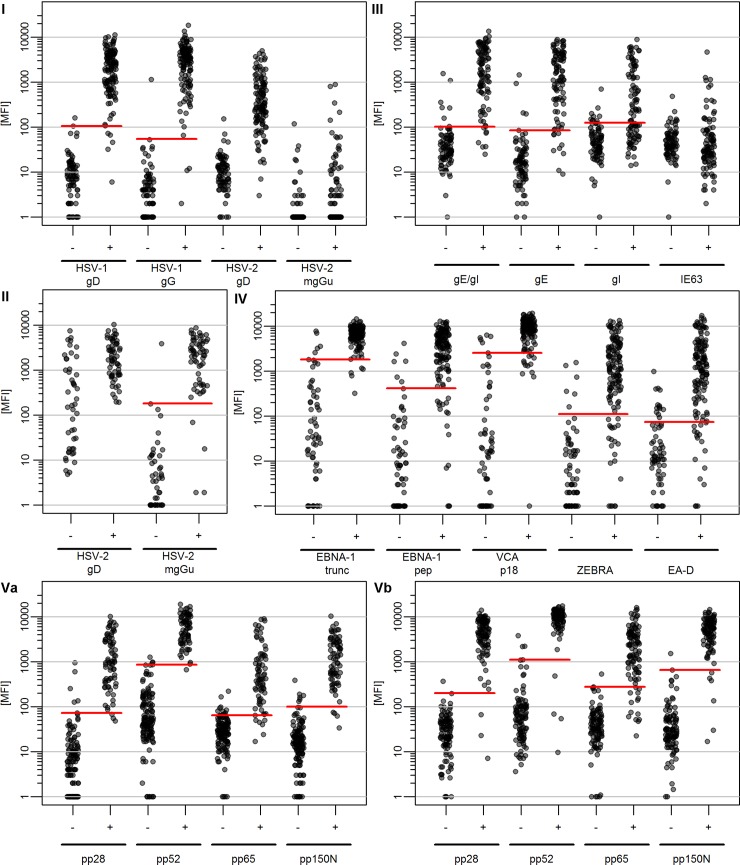
Comparison of quantitative antibody measurements (MFI) with reference serostatus in HHV species-specific Monoplex Serology.I-Vb indicate corresponding reference panels. gE/gI: co-loading of antigens gE and gI onto one bead set red lines: optimized cut-offs for single antigen performance; cut-offs were determined by optimizing specificity and sensitivity. MFI: Median Fluorescence Intensity.